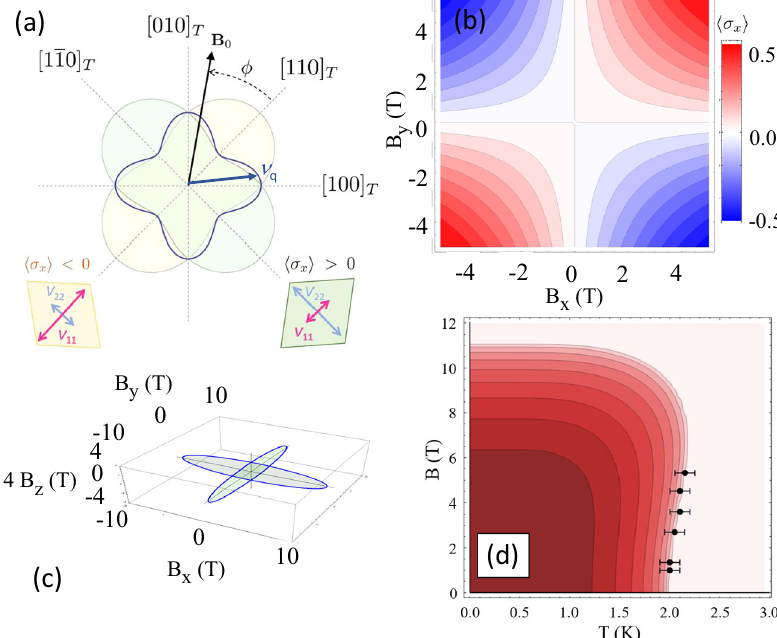
Fig. 2 Effect of in-plane fi elds on nematicity. a Polar plot of ν q as a function of fi eld direction for constant η > 0 (green) and η < 0 (yellow). The thick blue line shows ν q ( ϕ ) with angular-dependent η ( ϕ ). The diamonds indicate the two domains with negative shear strain, ε xy (order parameter 〈 σ x 〉 < 0, yellow) and positive strain ( 〈 σ x 〉 > 0, green). ϕ measures the angle relative to the [110] T direction in the tetragonal unit cell, such that ϕ = 0 lies along the B 2 g distortion direction. Note that η ∝ ε xy ∝ 〈 σ x 〉 . b Longitudinal fi elds induce fi nite order above T Q and smear out the phase transition. The ferroquadrupolar order parameter, 〈 σ x 〉 , is shown at T = 4 K > T Q as a function of fi eld direction in the plane perpendicular to the c -axis. The order parameter vanishes only for B x = 0 or B y = 0. c Quantum critical fi eld (blue) as a function of magnetic − B − B fi eld direction. The two intersecting ellipses are in the B x z and B y z planes respectively. d Calculated phase diagram for the effective model given by Eq. (5) with ξ = 0.002 T − 2 . Light colors correspond to 〈 σ x 〉 = 0 and darker red corresponds to increasing values of 〈 σ x 〉 . Solid black circles correspond to the peaks indicated by the blue arrows in Fig.